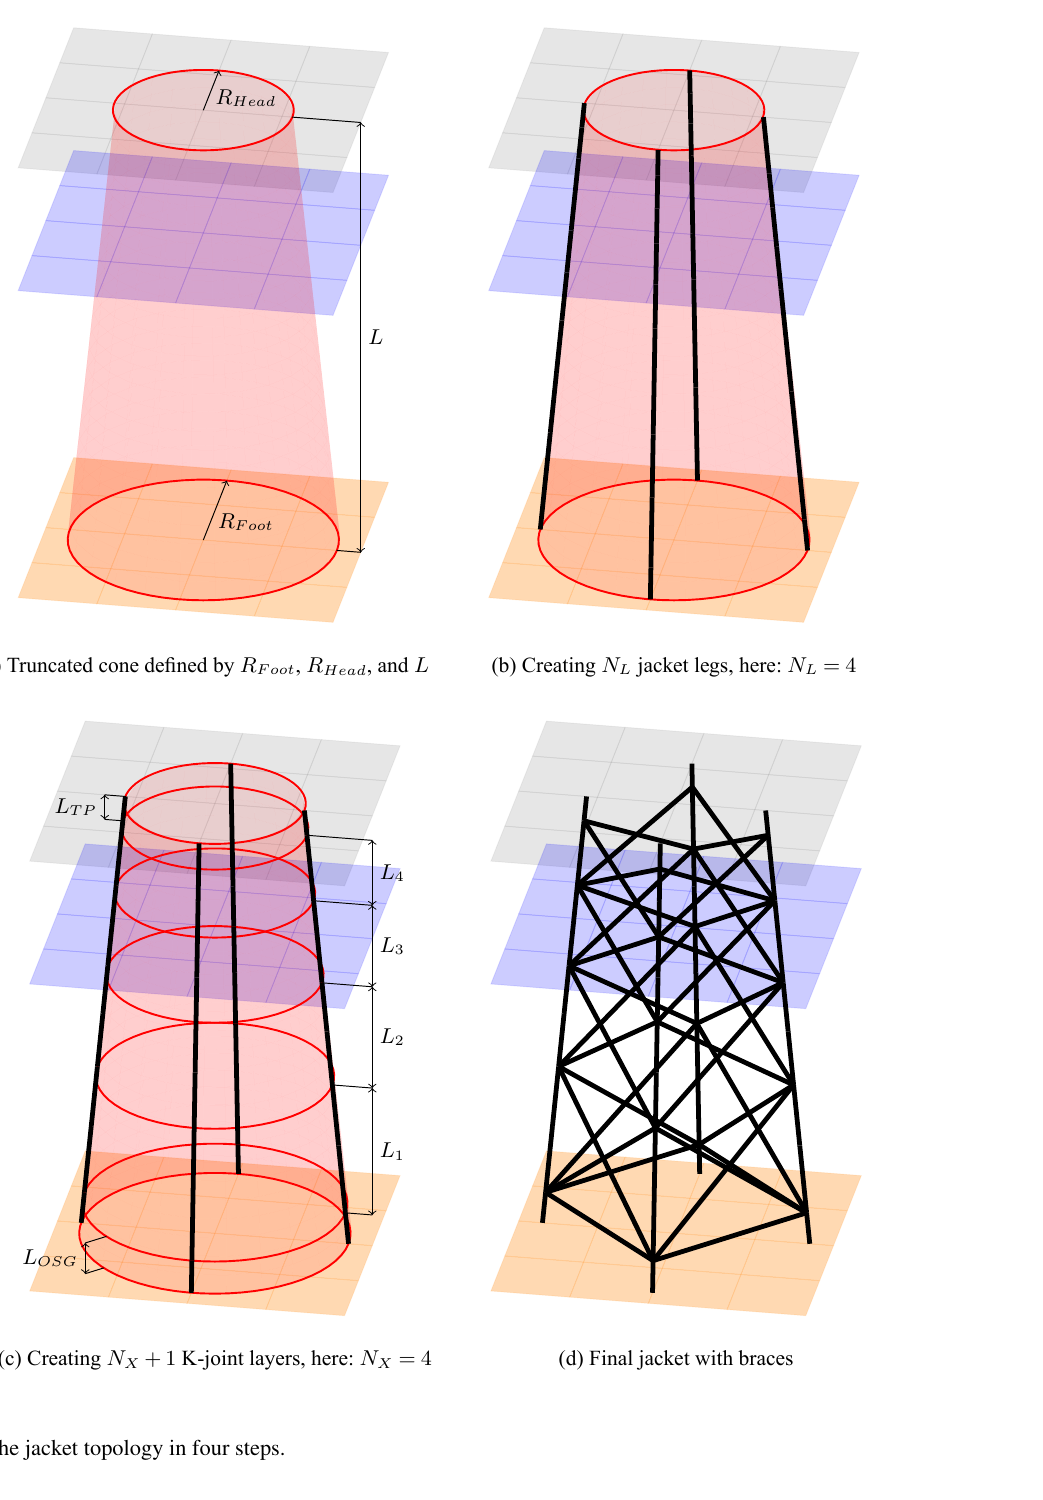
height of the X joints. Steps of β i and τ i are located on the height of the double-K joints in order to enable the use of constant tube sizes in each